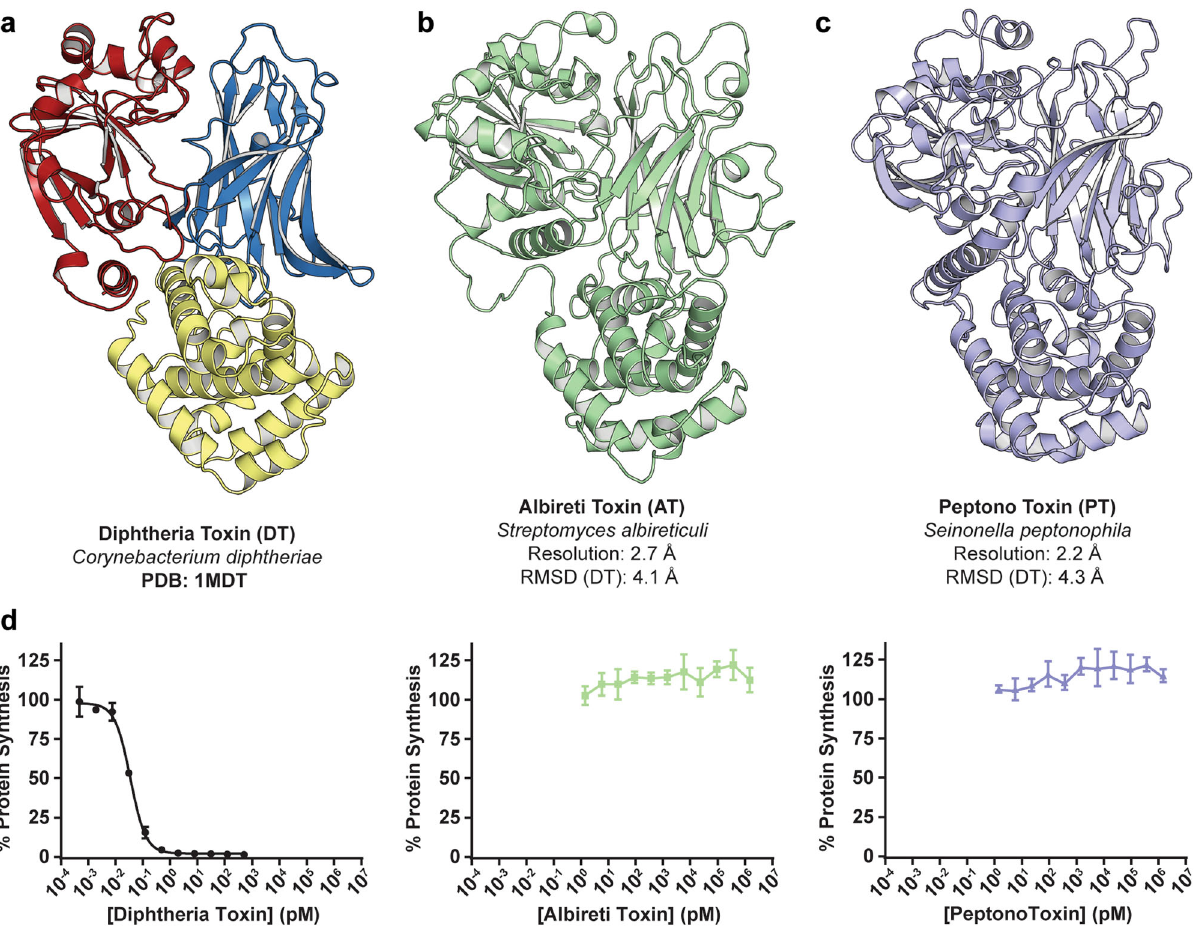
Fig. 2 Structures and functions of remote diphtheria toxin homologs. a Crystal structure of DT. b Crystal structure of AT solved by SAD-phasing and re fi ned to R and R free values of 20.2% and 24.8% (PDB: 7RI3). The four monomers in the ASU align to each other with RMSDs of <1.0 Å. A complete model was built in each of the four chains, except for 4 – 5 residues from the N-terminus and 0 – 10 residues from the loop joining the catalytic and translocation domains. Shown is the most complete of the four chains, c crystal structure of Peptono Toxin solved by SAD-phasing and re fi ned to R and R free values of 20.2 and 22.5% (PDB: 7RB4). A complete model was built for the monomer in the ASU, apart from the fi rst three N-terminal residues. d Dose titrations of DT, AT, and PT on DT-sensitive Vero cells (mean ± SD, n = 4); n = 3 biological